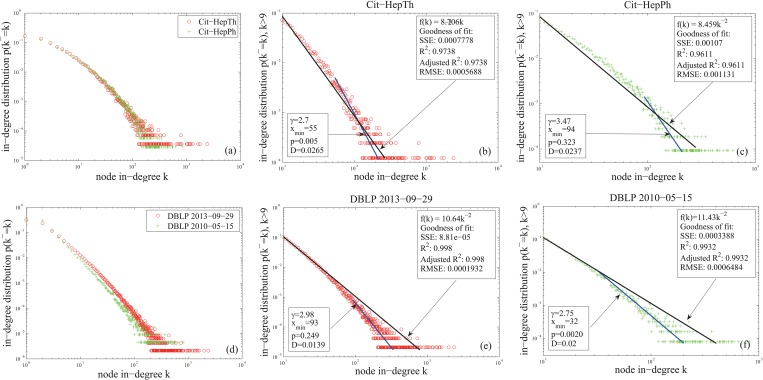
In-degree distributions of the citation networks in Table 1.Panels(b, c, e, f) show the fitting effects of the in-degree distributions of the nodes with in-degree larger than 9 by the power-law functions f(k) = ak
−2 and f(k)=k−γ∑n=0∞(n+xmin)−γ.